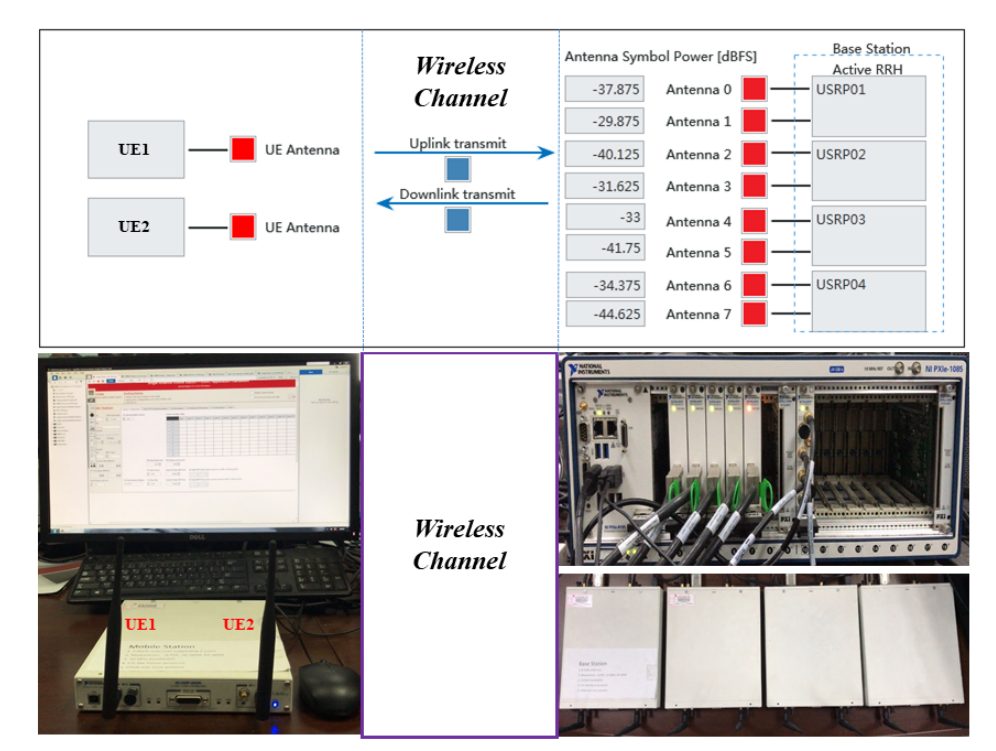
Figure 2. Hardware setup of SDR platform: two single-antenna users and 8-antenna